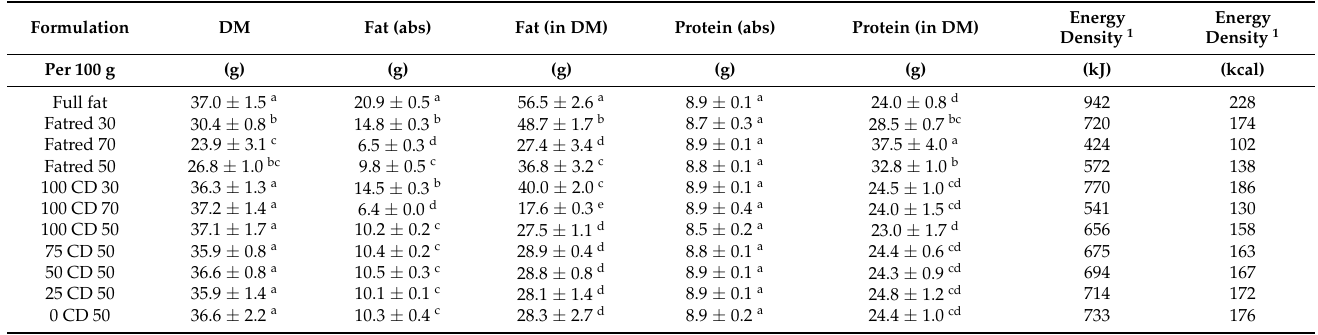
Table A1. Composition of the samples based on 100 g model processed cheese spread (abs = absolute, DM = dry matter, CD = corn dextrin).